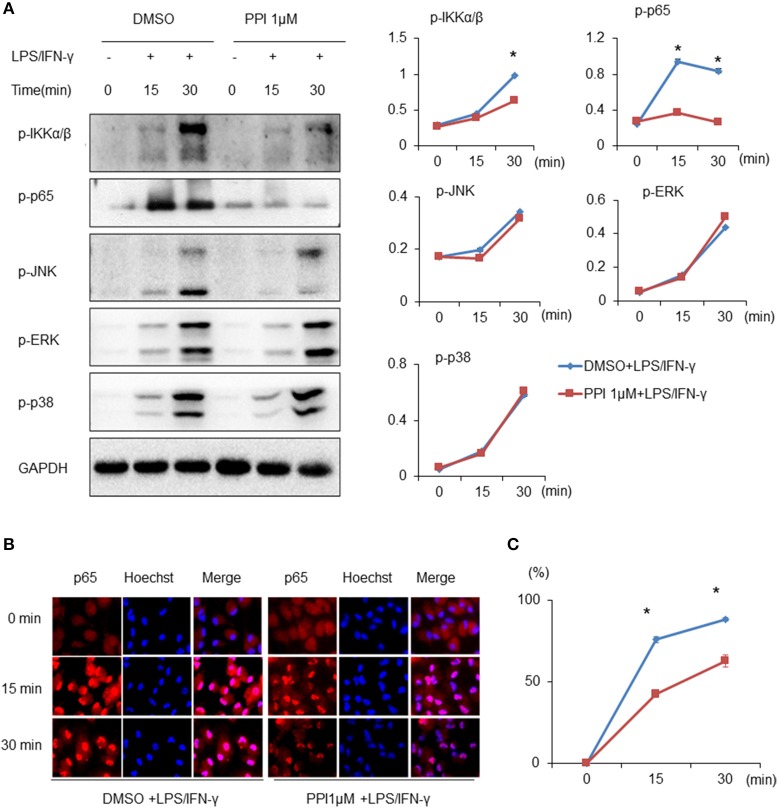
PPI ameliorated the phosphorylation of IKKα/β and p65, and p65 nuclear accumulation, without any effect on MAPK signaling under the stimulation of LPS/IFN-γ. (A) Immunoblots for phosphorylation of IKKα/β, p65, JNK, ERK, p38, and the protein level of GAPDH in cell lysates of BMMs stimulated with LPS (1 μg/ml)/IFN-γ (100 ng/ml) for 15, 30, and 60 min in the presence of PPI (1μM) or the same volume DMSO pretreated for 3 h. Blot is representative of three independent experiments. The normalized density of was shown on the right. Data represent mean ± SEM of three pooled experiments. *P < 0.05, two-way ANOVA. (B, C) PEMs were unstimulated or stimulated with LPS (1 μg/ml) /IFN-γ (100 ng/ml) for 15, 30, and 60 min in the presence or absence of PPI pretreatment for 3 h. The cells were stained with anti-p65 (in red) and Hoechst (in blue). Representative 100 × images. More than 300 cells from each sample were measured. The values are the mean ± SEM. The experiment was repeated at least three times. *P < 0.05, two-way ANOVA.